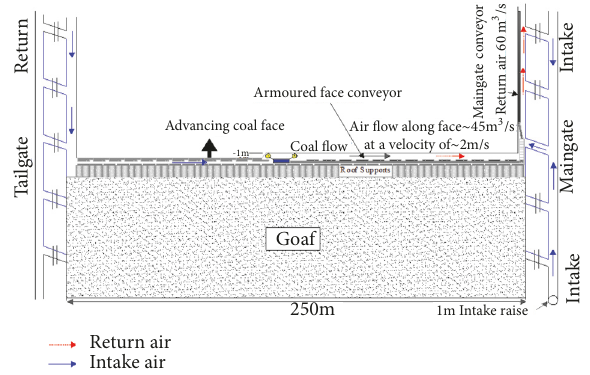
Figure 11: Full homotropal ventilation system.